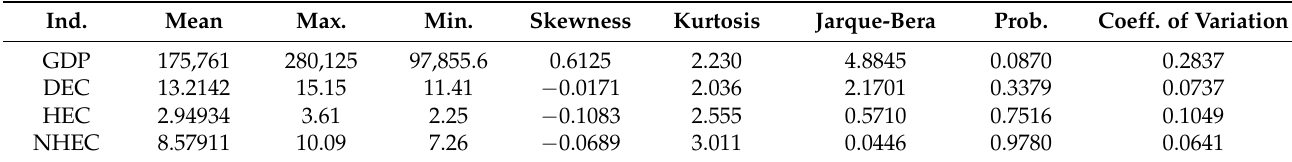
Table A3. Statistical analysis of